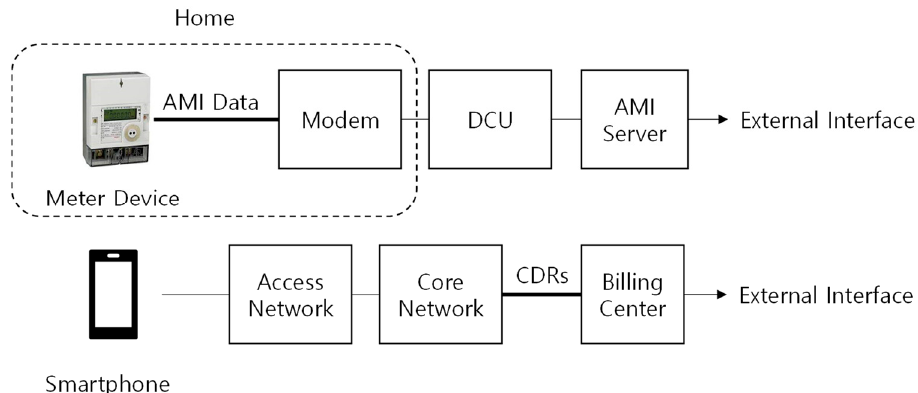
Figure 1. Data generation process in power and communication systems.